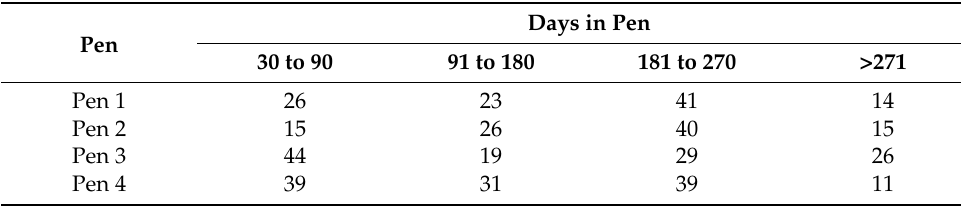
Table 2. Number of cows and range of the time (day) spent by pen during the 12-month study period (February 2019–February